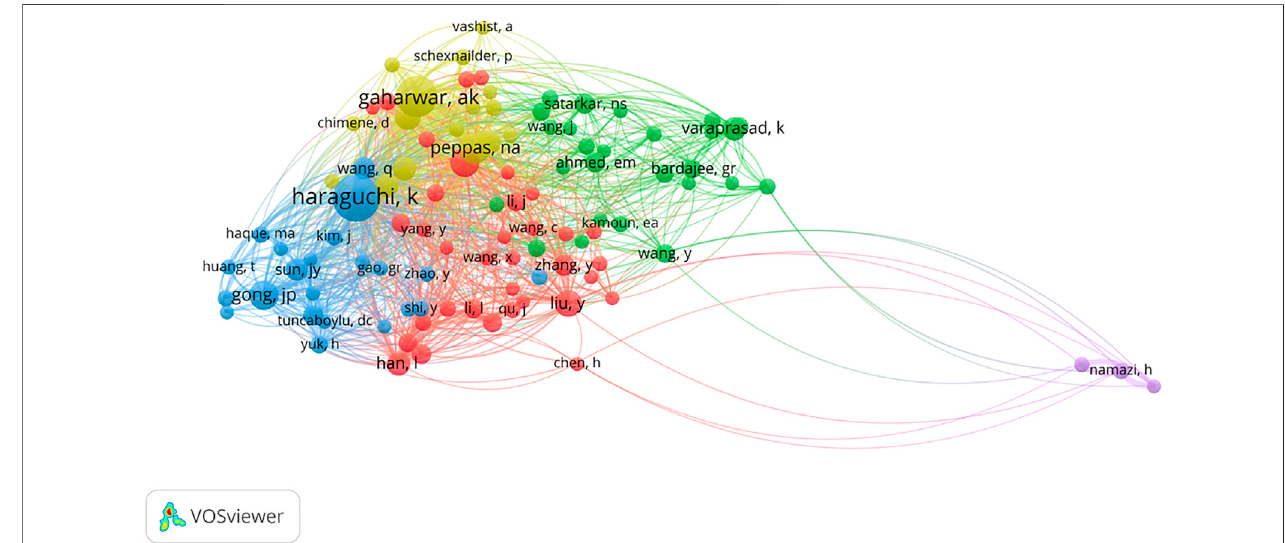
FIGURE 6 | VOSviewer network visualization map based on co-cited authors in nanocomposite hydrogel.